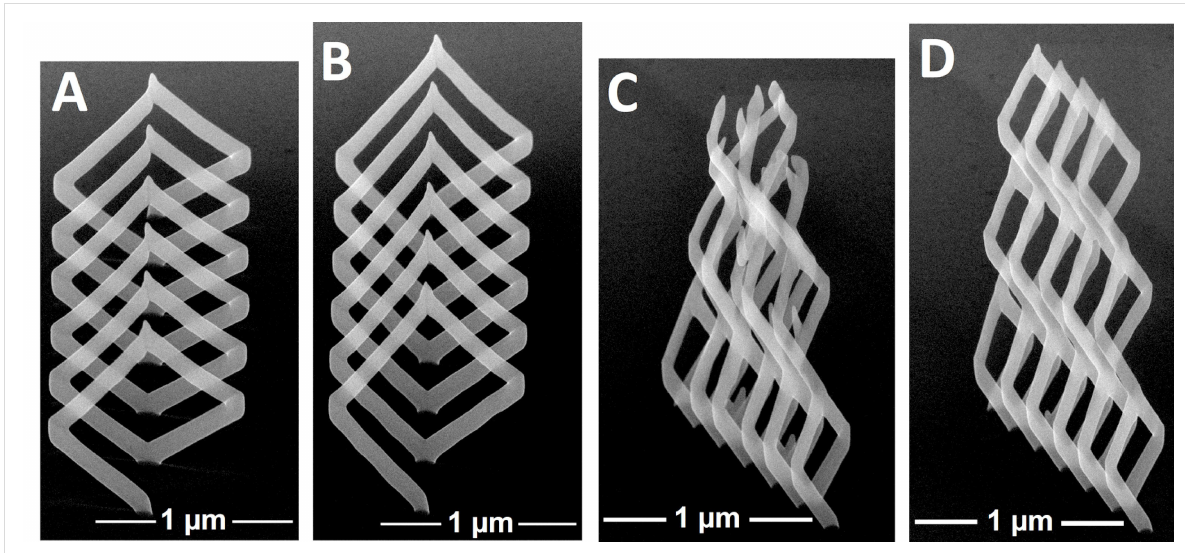
Figure 9: Comparison of the angle-sorted proximity avoiding algorithm (asPAA) and the best permutation PAA (bpPAA). All images are taken at 52° tilt angle. The pattern files for A and C were generated with the asPAA, for B and D with the bpPAA. Note the different height mismatches of the left and right edges of A, in contrast to B. C and D are three horizontally aligned coils stacked on top of each other. B (1.37 μ m) is taller than A (1.09 μ m) and D (2.46 μ m) is taller than C (2.38 μ m) due to more efficient use of precursor. Precursor: Me 3 CpMePt(IV), high resolution mode.